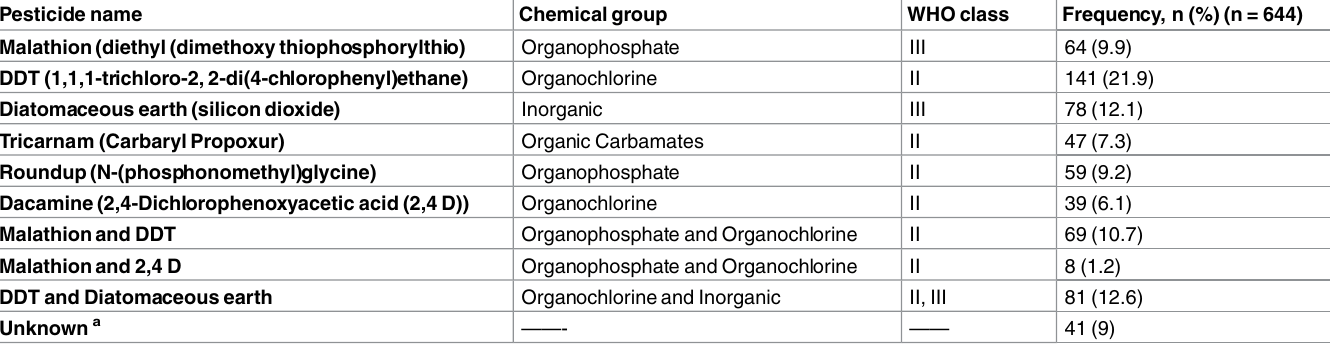
Table 4. Pesticidesreportedas used by farmers in ruralirrigationvillages. Pesticide